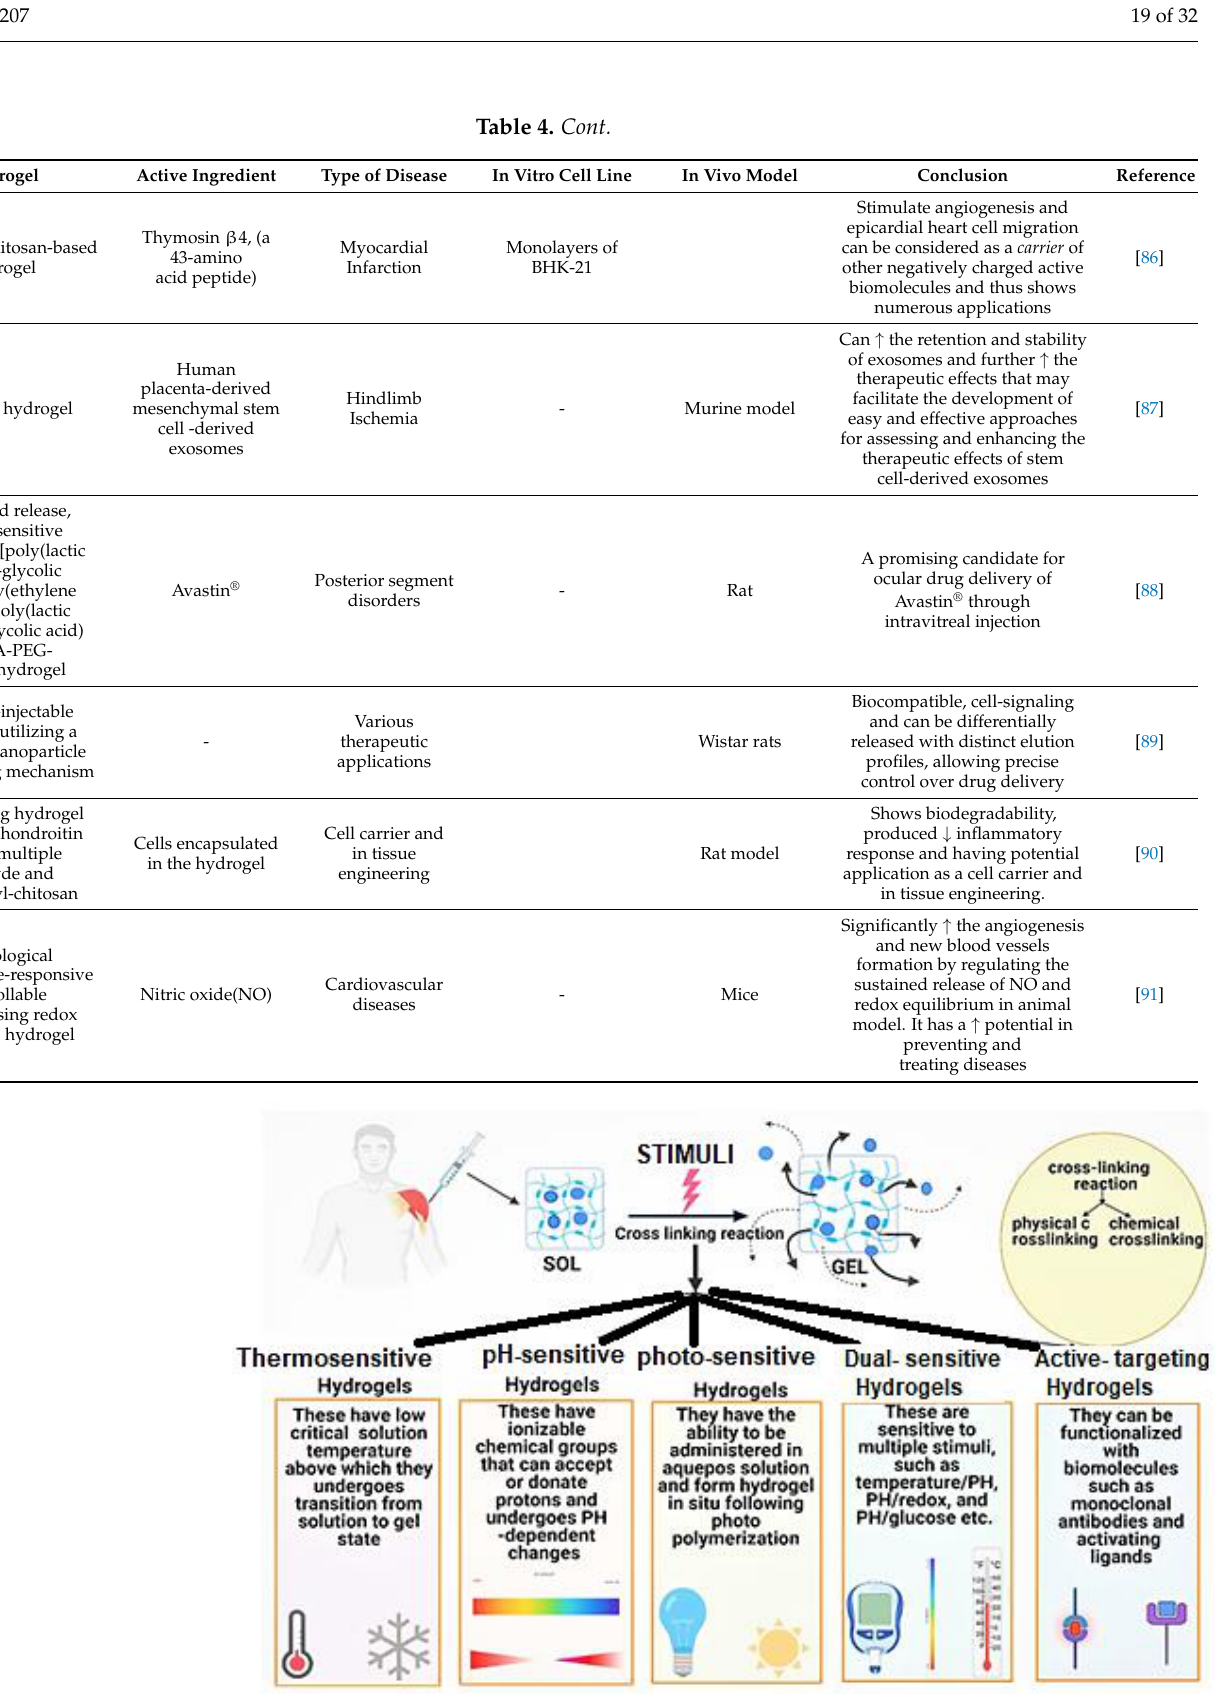
Figure 6. An overview of various aspects of injectable hydrogels.